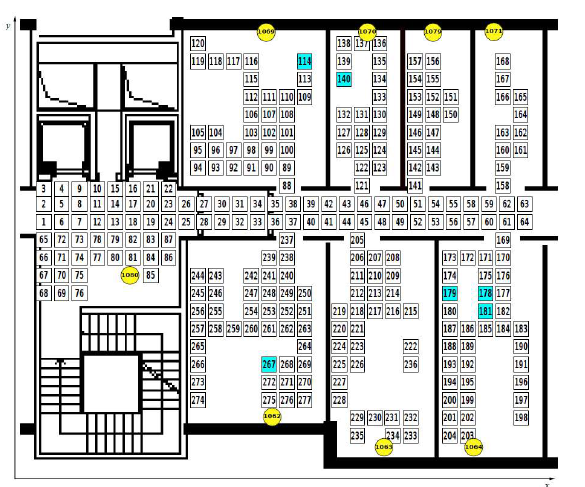
Figure 8. Overview of the test environment